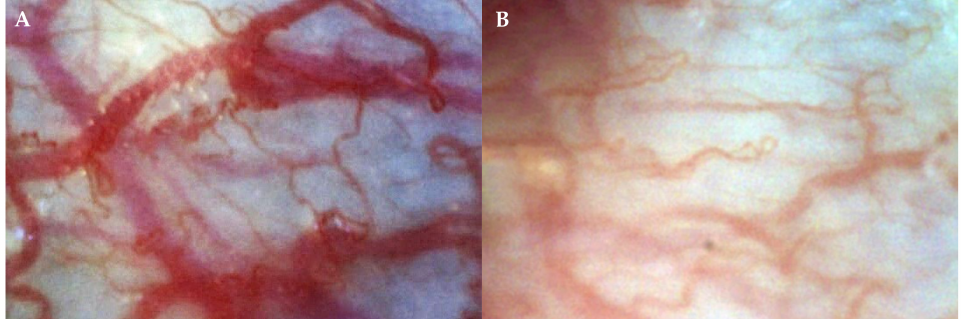
Figure 1. Capillaroscopic gingival microcirculation pictures of chronic generalized periodontitis subject ( A ) and healthy subject ( B ) (original magnification × 300).